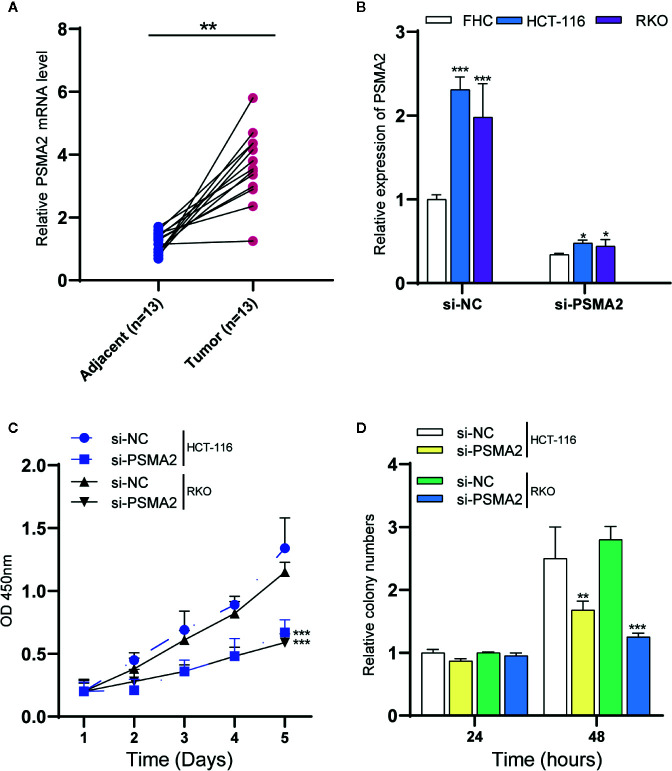
PSMA2 promotes CRC cell proliferation. (A) PSMA2 mRNA is up-regulated in CRC samples using clinical samples. (B) Transfecting with si-PSMA2 significantly reduced the PSMA2 expression in FHC and two colorectal cancer cell lines. (C) PSMA2 silencing declined RKO and HCT-116 cell proliferation using CCK-8 assay. (D) PSMA2 silencing suppressed the colony formation abilities of RKO and HCT-116 cell. *P < 0.05, **P < 0.01, ***P < 0.001.